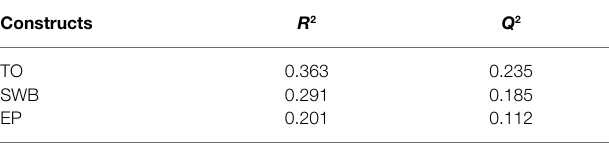
TABLE 4 | Assessment criteria R 2 and Q 2 for the structural model.